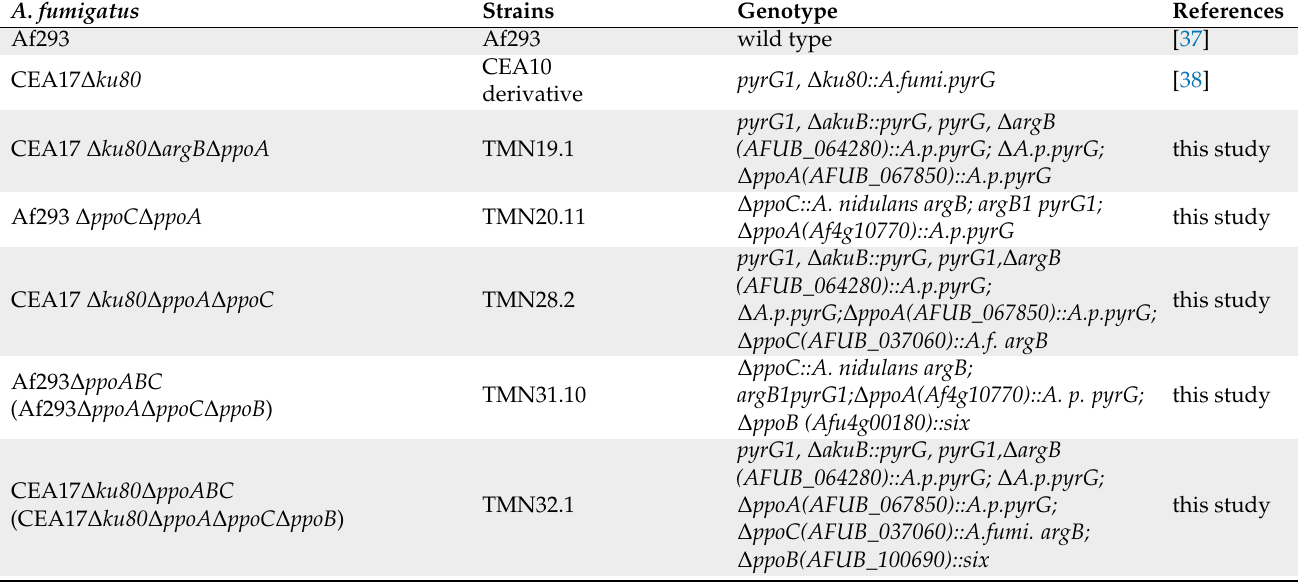
Table 1. Aspergillus fumigatus and Drosophila melanogaster strains used in this study. A. fumigatus Strains